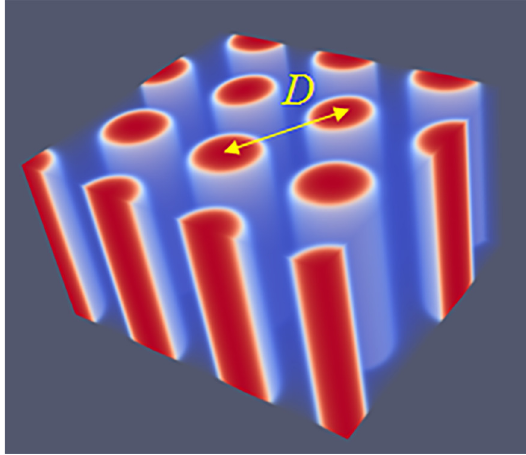
Figure 3. SF-SCF predictions for the density profile of HEX phase for D = 60, N = 1000, χ N = 30 and f = 0.30. The spacing D is indicated. Color coding is as follows. Regions rich in the minority block (segment type A) are given in red, and the blue regions are rich in the majority phase (segment type B). The majority phase (blue) is made more transparent the higher its density is for presentation purposes. Mirror-like boundary conditions apply in all